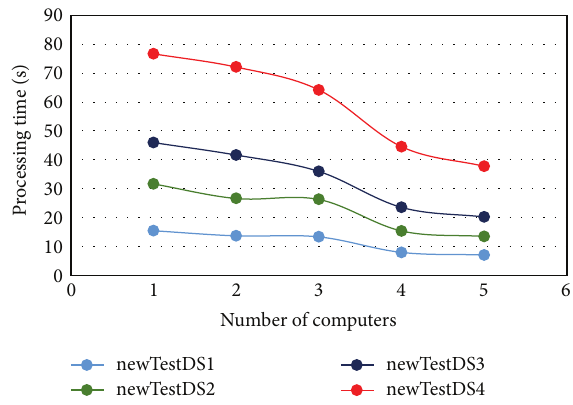
Figure 12: The cost of system resources